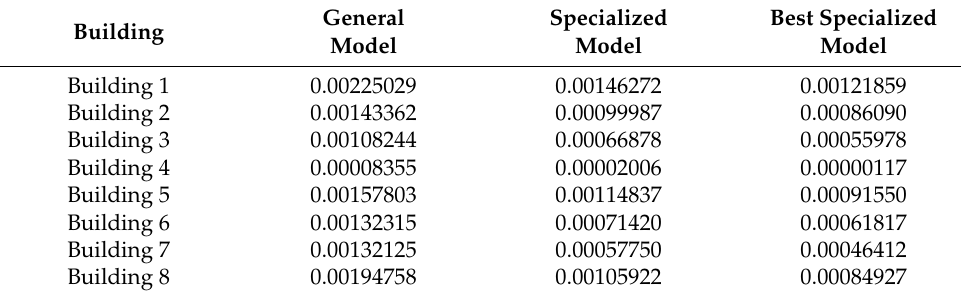
Table 7. Error comparison between each of the